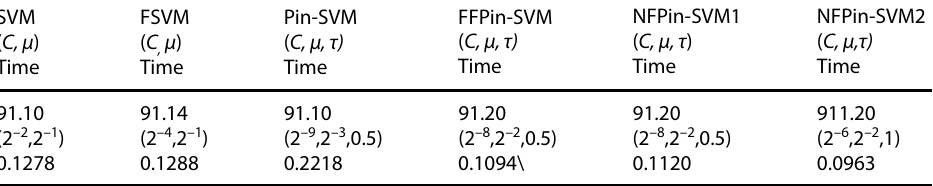
Table 2 The performance comparison of our